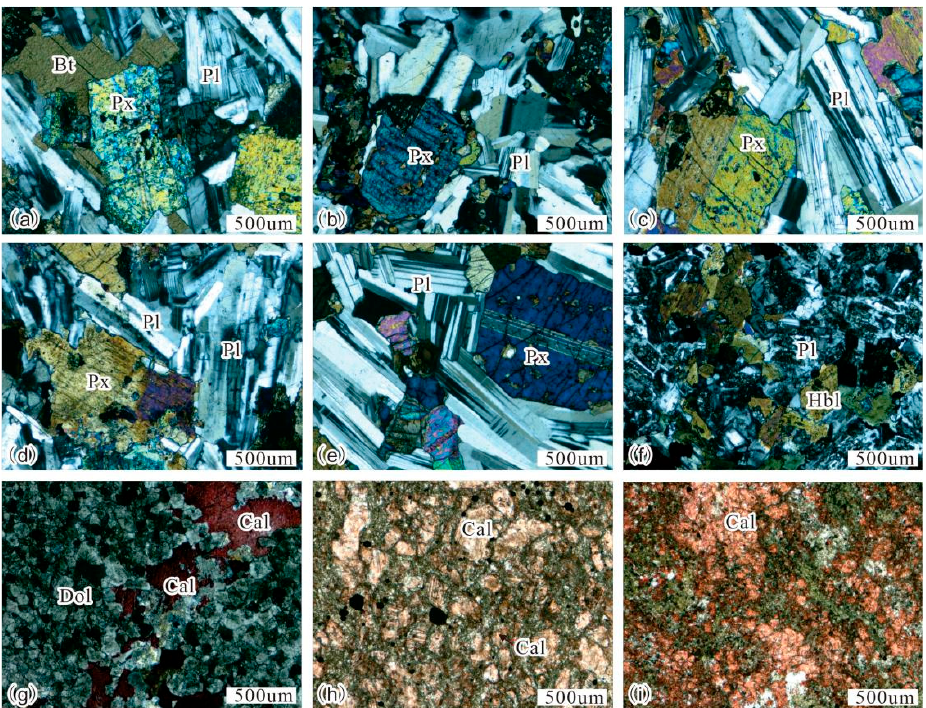
Figure 3. Microscopical features of the rock samples in the study area ( a – e ) are gabbros, ( f ) is diorite, and ( g – i ) are carbonate rocks). ( a )—Plagioclase: 48–50%; Pyroxene: 43–45%, cleavage developed;